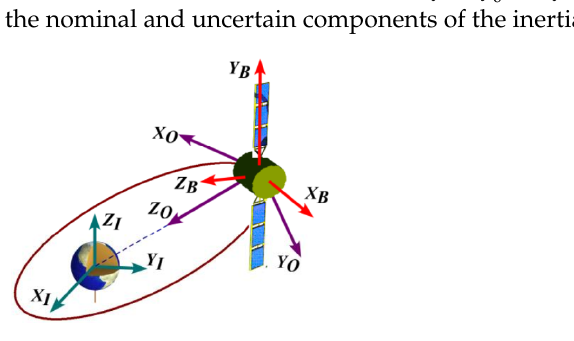
Figure 1. Coordinate reference frames.